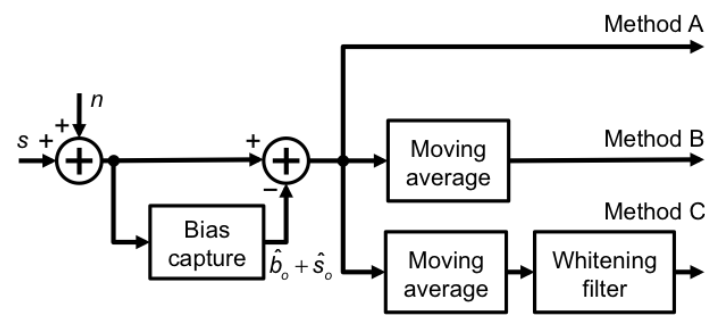
Figure 2. Tested methods of signal processing.